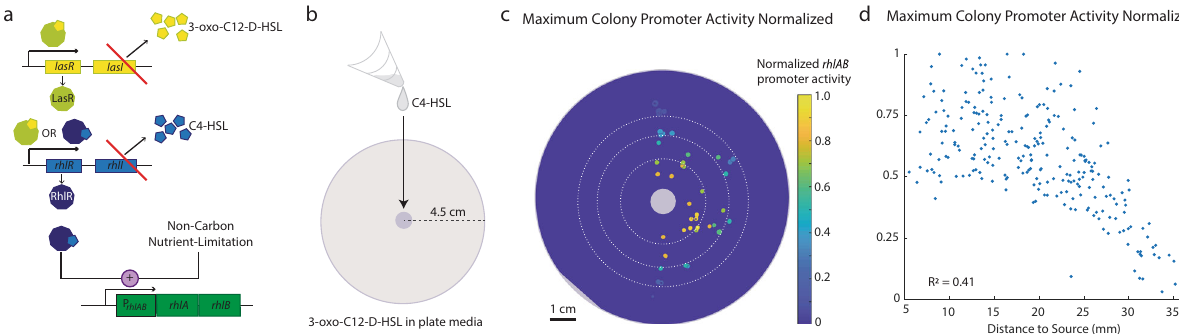
Fig. 2 P. aeruginosa responds to diffusive quorum signals in a distance-dependent manner. a The native molecular circuit determining rhlA expression. Red lines describe clean deletions present in a signal mute quorum signal mutant. b Experimental design to investigate the length scale of quorum signal response. c Colonies viewed at their 24 h size colored by the maximum promoter activity achieved across the colony ’ s timeseries. Data has been normalized. d Maximum promoter activity achieved by each colony plotted with respect to the distance between the center of the colony and the center of quorum signal source. Data from three independent biological replicates is shown, with 40, 69 and 139 colonies respectively. Data are normalized to the highest promoter activity observed for the dataset to correct for batch